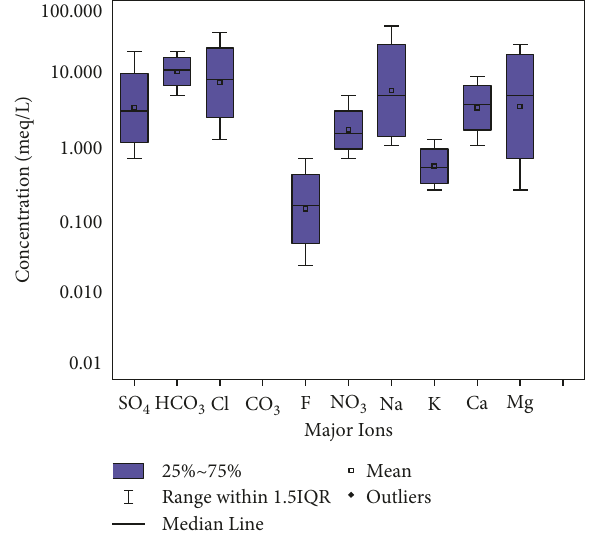
Figure 2: For significant cations and anions, a box and whisker